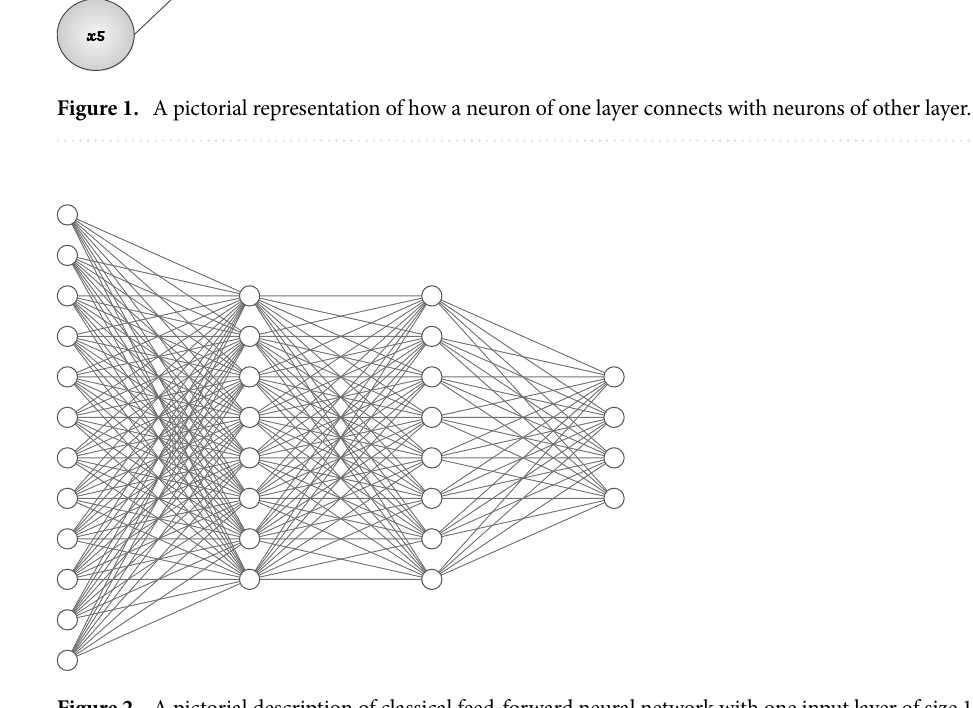
Figure 2. A pictorial description of classical feed-forward neural network with one input layer of size 12, two hidden layers each of size 8 and an output vector of length 4. This figure has been generated using a tool developed by Alex LeNail https:// alexl enail. me/ NN-